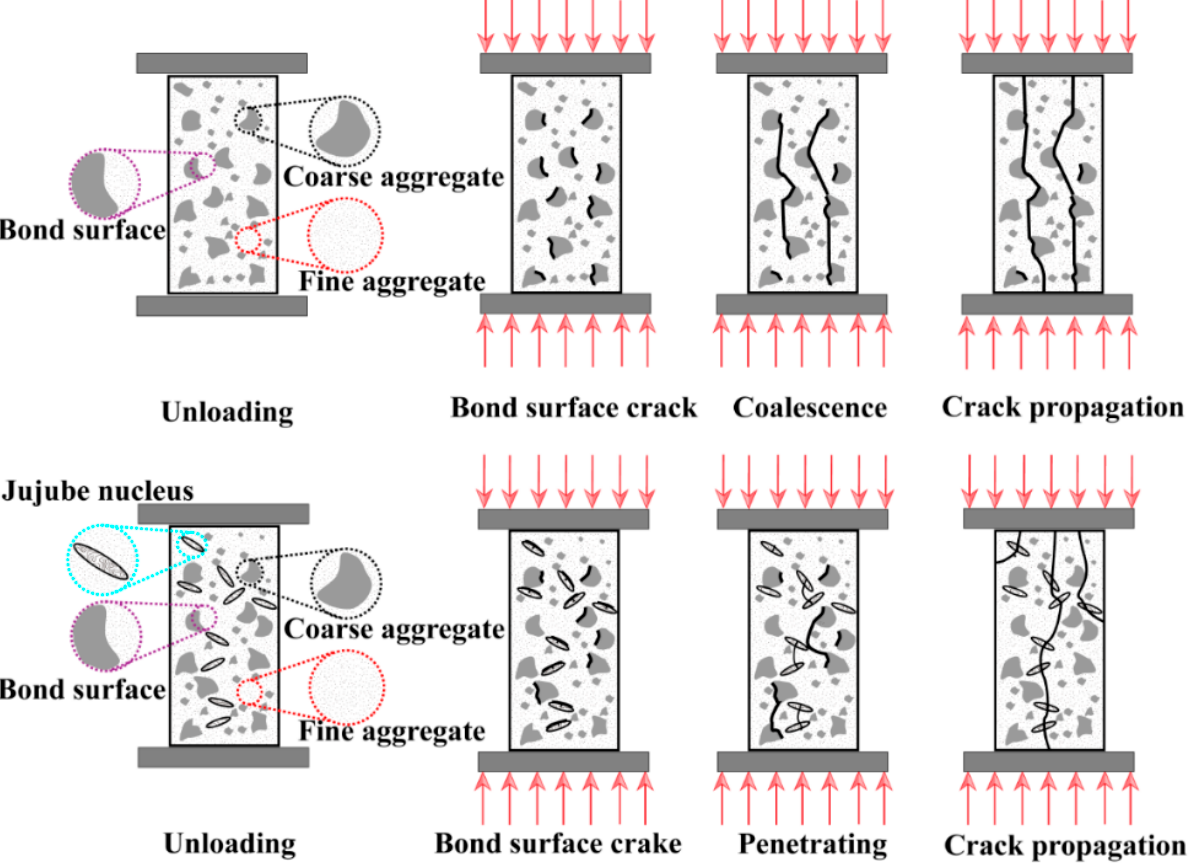
Figure 9. The fracture mechanism of jujube nucleus concrete.